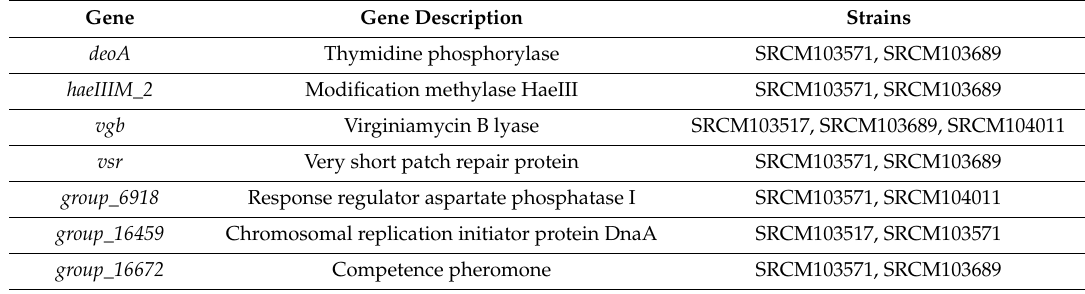
Figure 4. Pangenome analysis results using B. subtilis strains available with complete genome sequences in NCBI with selected B. subtilis strains from Korean traditional fermented food. ( A ) Upper: Pangenome analysis results using 32 B. subtilis strains available with complete genome sequences in NCBI and 5 strains from Korea in this study. Lower: Core genes of selected B. subtilis 5 strains from Korea and all 37 strains using the COG database. ( B ) Upper: Pangenome analysis results using 24 B. subtilis strains from Korea in another study available with complete genome sequences in NCBI and 5 strains from Korea in this study. Lower: Core genes of 5 B. subtilis strains from Korea in this study and all 29 strains from Korea in this and other studies using the COG database. J, Translation, ribosomal structure, and biogenesis; K, Transcription; L, Replication, recombination, and repair; D, Cell cycle control, cell division, and chromosome partitioning; V, Defense mechanisms; T, Signal transduction mechanisms; M, Cell wall / membrane / envelope biogenesis; N, Cell motility; O, Posttranslational modification, protein turnover, and chaperones; C, Energy production and conversion; G, Carbohydrate transport and metabolism; E, Amino acid transport and metabolism; F, Nucleotide transport and metabolism; H, Coenzyme transport and metabolism; I, Lipid transport and metabolism; P, Inorganic ion transport and metabolism; Q, Secondary metabolite biosynthesis, transport, and catabolism. Table 1. Newly isolated Bacillus subtilis -specific genes that are not present in Chinese and Japanese strains. Gene Gene Description